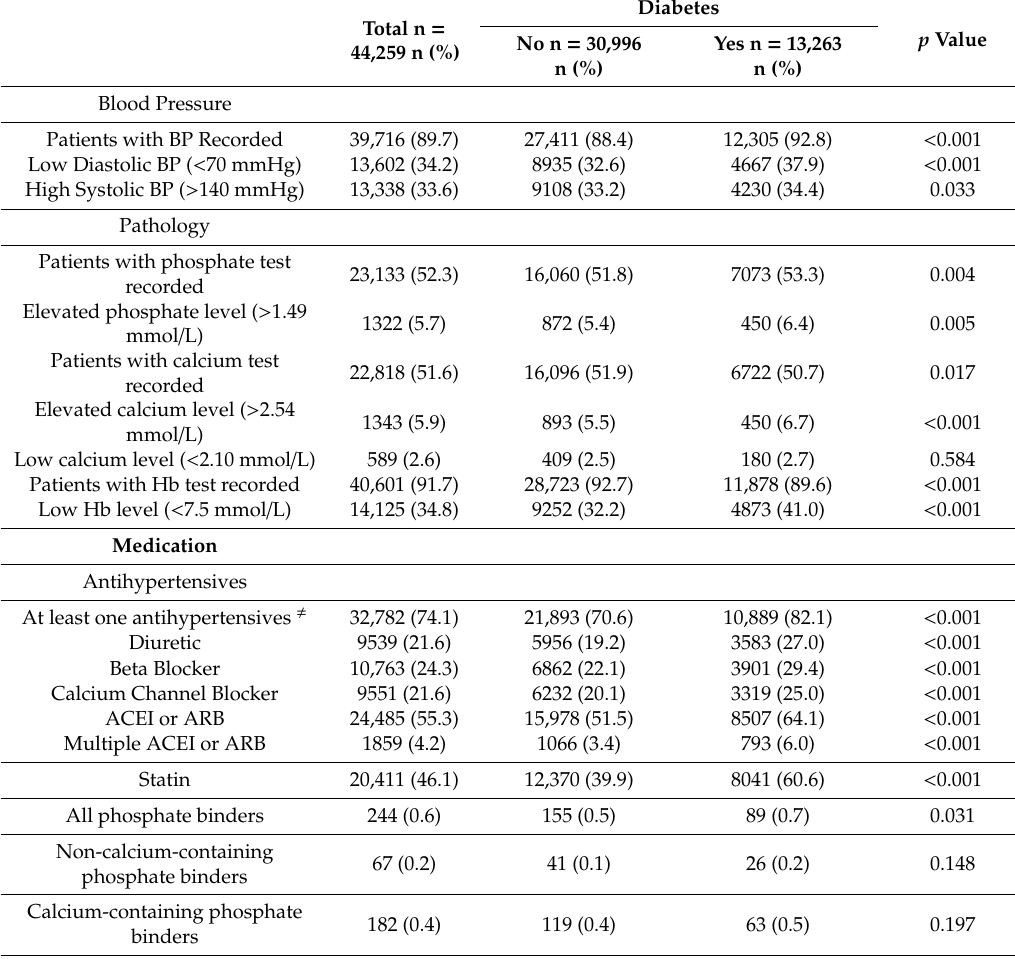
Table 3. Proportion of patients with CKD receiving monitoring and medications by diabetes